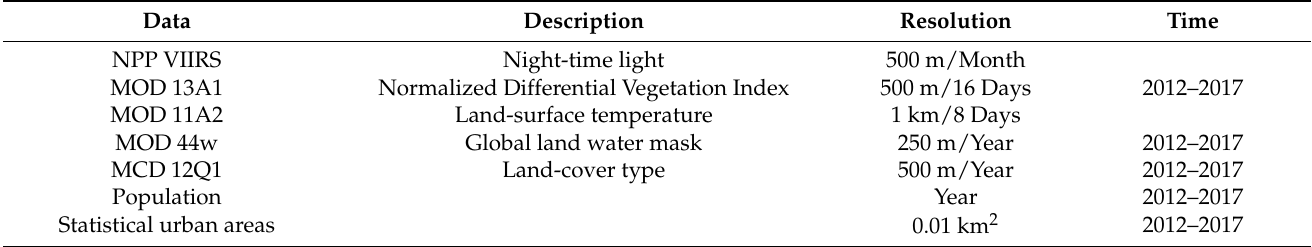
Table 1. Data used in this